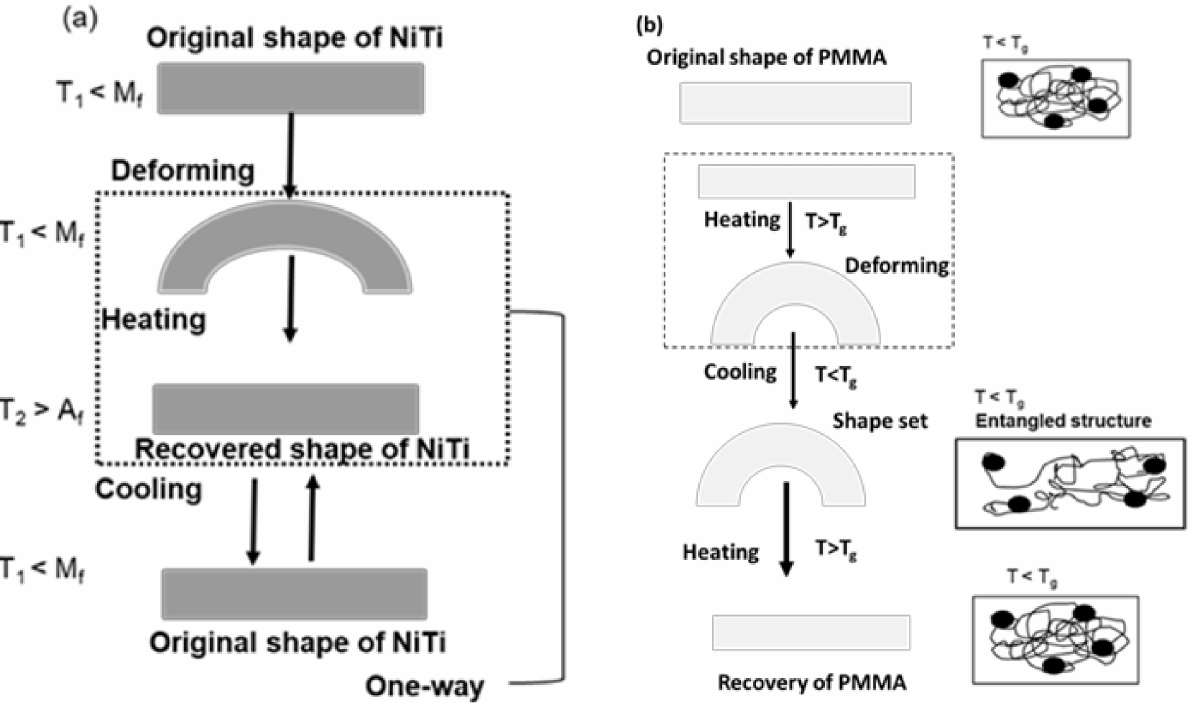
Figure 1. ( a ) One-way shape memory effect of NiTi alloy; ( b ) Shape change and recovery of